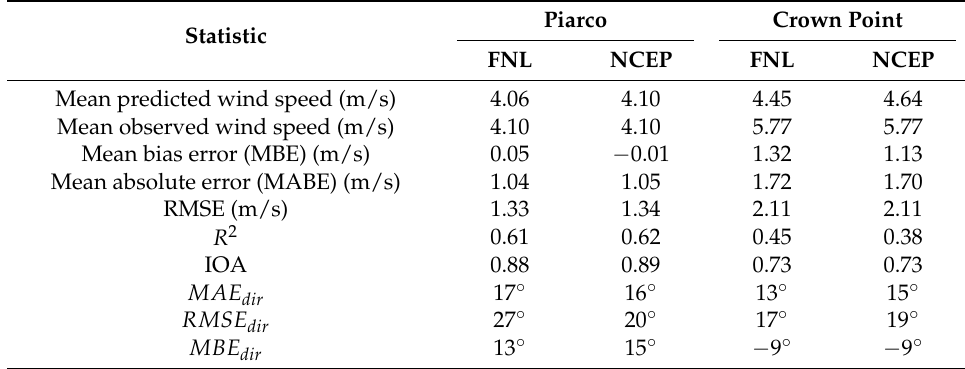
Table 1. Model and error statistics of WRF’s 10 m level wind speed and wind direction at Piarco and Crown Point using FNL and NCEP-DOE analyses as initial/boundary conditions. WRF was run with two nests and modeled wind speeds were found on the inner-most domain which has horizontal resolution of 1 km (DO3 on Figure 1). Error statistics with the “dir” subscript refers to the error in wind direction. Error statistics were computed for 720 h of simulated